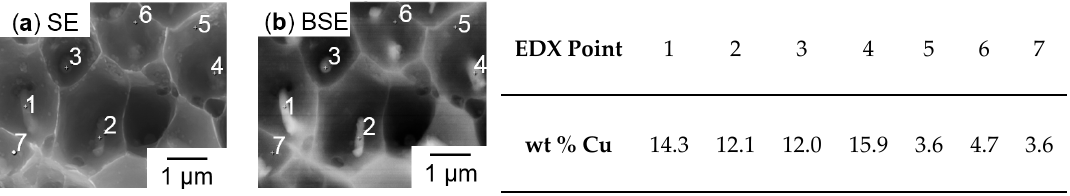
Figure 10. ( a ) Secondary electron (SE) and ( b ) back scattered electron (BSE) contrasts of the same region of the fracture surface of a non-heat-treated vertical sample reveal spots of different elements.